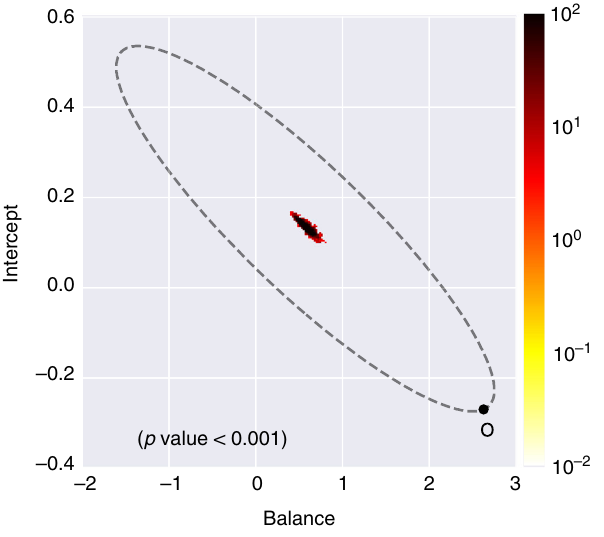
Fig. 5 Hot hand Logit regression social balance signi fi cance, P < 0 : 001. This fi gure shows the results of 10,000 null models randomizing the networks, point O represents coef fi cient from the observed networks, dots in the middle of oval represent those of randomized networks and the color shows their distribution. The coef fi cients for the observed model are signi fi cantly different from randomized networks with the same in and out-degree distribution. It depicts the observed balance-hot hand relationship cannot be explained by